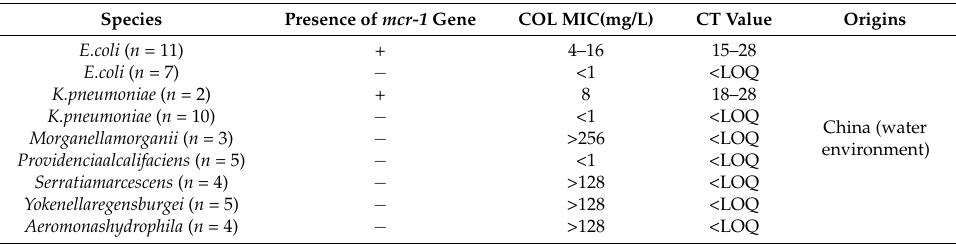
Table 2. Presentation of the specificity of the qPCR assay.